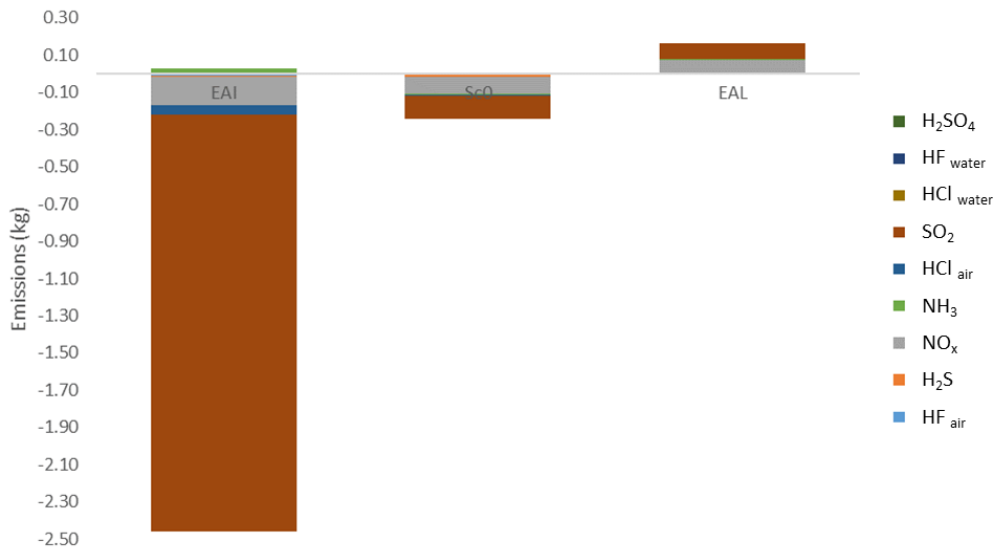
Figure 5. Acidification potential comparison for the reference case (Sc0) among average European scenarios. Results refer to one tonne of treated residues.